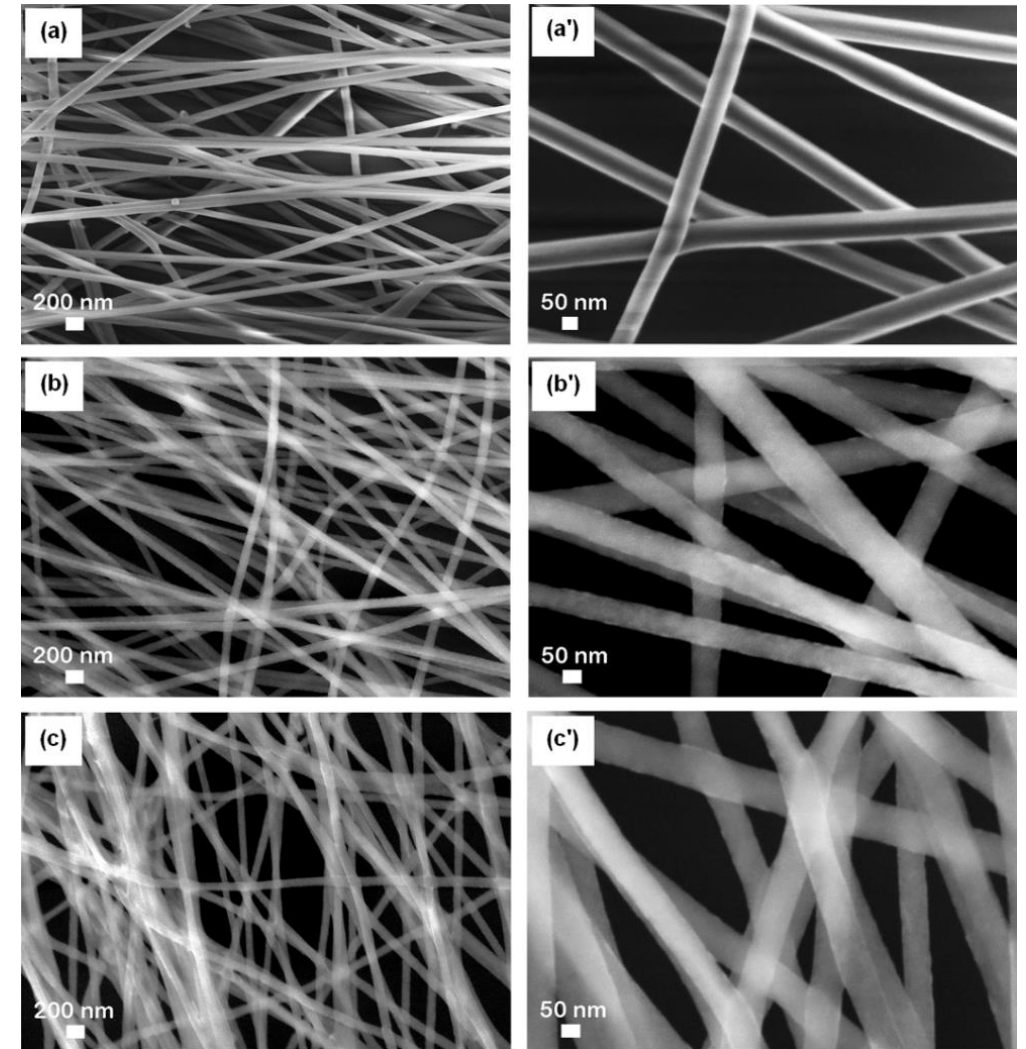
Figure 5. Representative FESEM images at different magnification of ( a , a’ ) nylon, ( b , b’ ) nylon-ZnO and ( c , c’ ) nylon-ZnO/PPy, respectively.